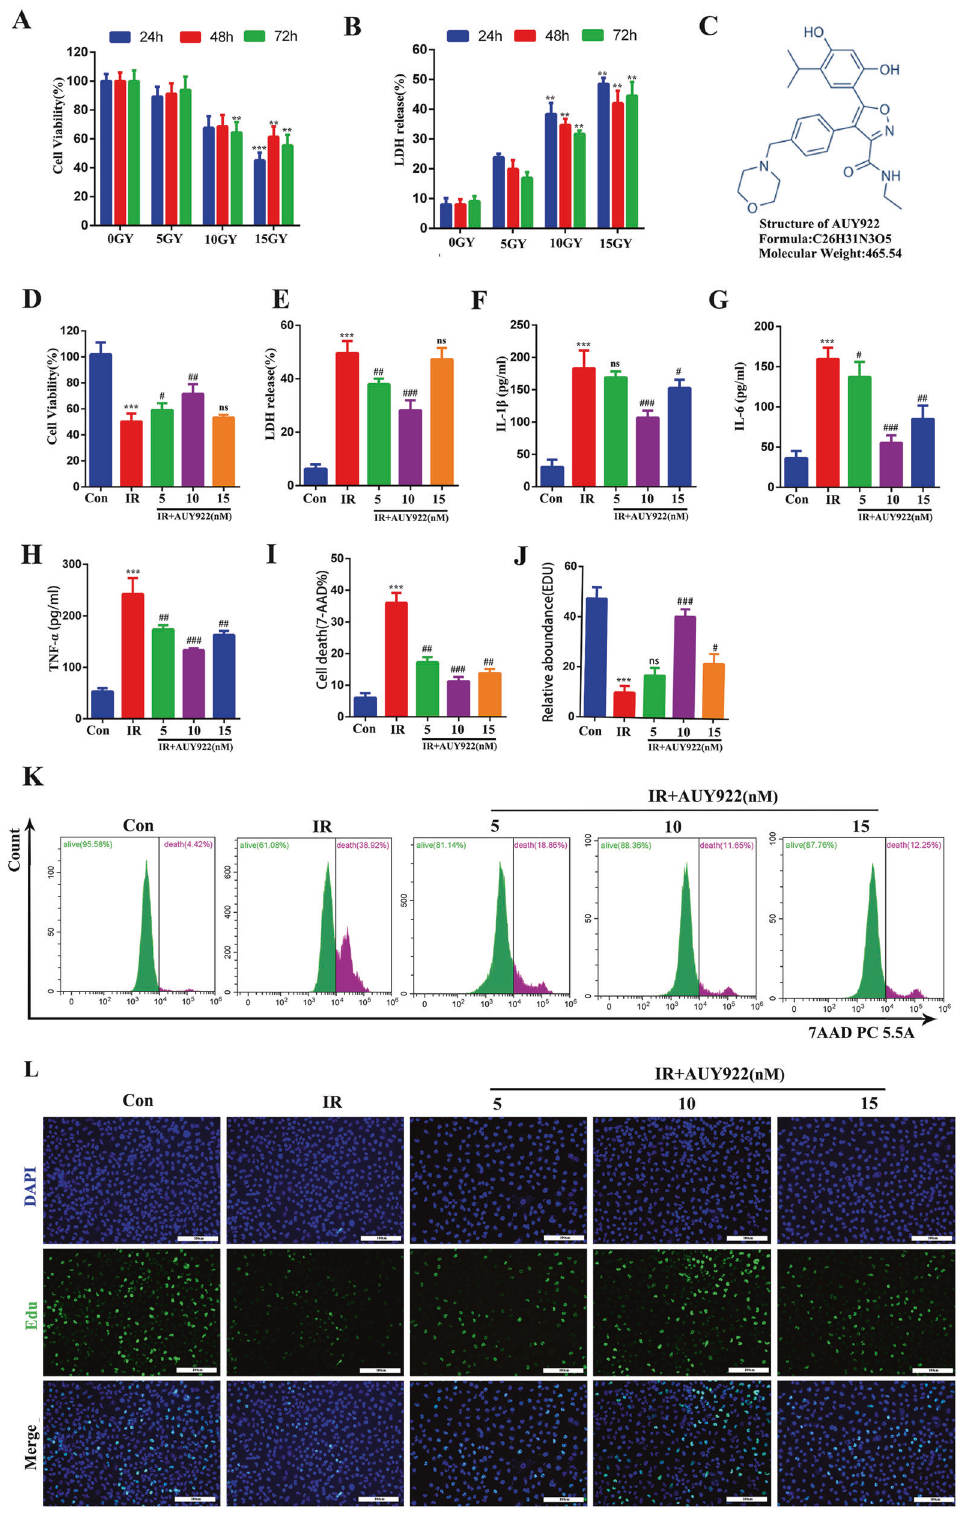
Fig. 1 NVP-AUY922 alleviates radiation-induced BEAS-2B cell injury. A , B Cell viability and LDH release assay was detected at different time points (24, 48, or 72 h) following radiation (0, 5, 10, or 15 Gy). C The chemical structure of NVP-AUY922. D , E Cell viability and LDH release assay in BEAS-2B. F – H Concentrations of IL-1 β ( F ), IL-6 ( G ), and TNF- α ( H ) in cell culture supernatant. I , K Representative fl ow cytometric images. J , L Representative EDU assay fl uorescence images. All data are expressed as the mean ± SD. ( n = 6). #/ * P < 0.05, ##/ ** P < 0.01, ###/ *** P < 0.001, # vs. IR group; * vs. control